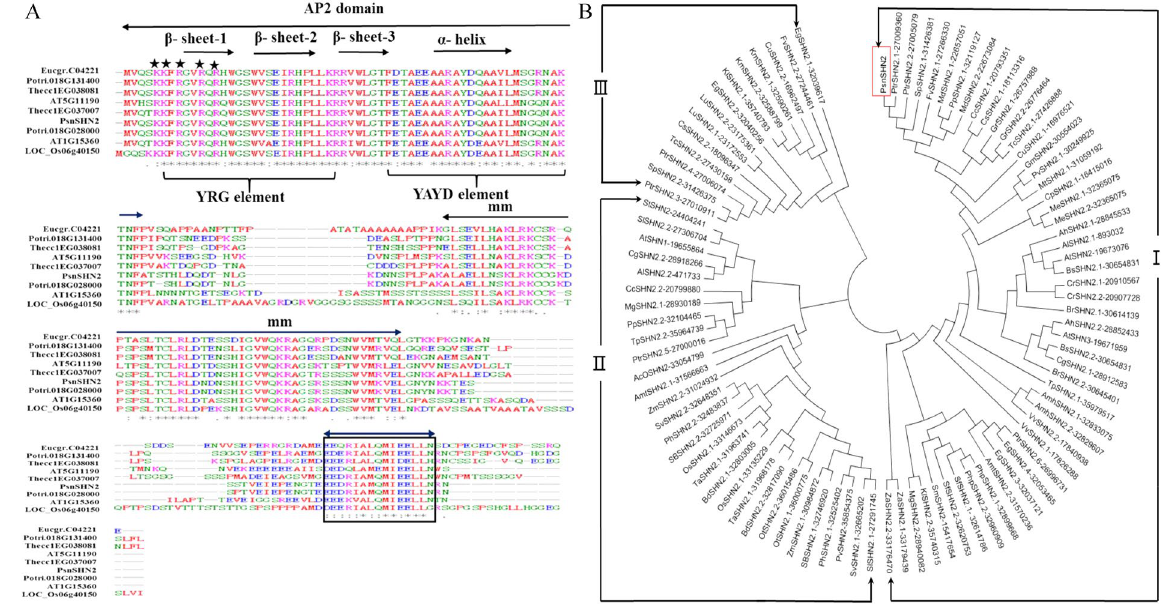
Figure 1. Protein sequence alignment and phylogenetic analysis of PsnSHN2 . ( A ) PsnSHN2 was aligned with SHINE proteins from Populus trichocarpa (Potri.018G028000 and Potri.018G131400), Eucalyptus globulus (Eucgr.C04221), Theobroma cacao (Thecc1EG038081 and Thecc1EG0370070), Oryza sativa (LOC_ Os06g40150) and Arabidopsis thaliana (AT1G15360 and AT5G11190). The conserved YRG and RAYD elements in AP2 domain are indicated by brackets. α helix is indicated by an arrow; cm stands for c-terminal domain while mm represents middle domain; Asterisks mark the putative domains for nuclear localization signals; the boxed region indicates the putative activation domain. ( B ) Phylogenetic analysis of PsnSHN2 with other SHINE proteins. 93 SHINE genes of 44 species are available in Supplemental file. PsnSHN2 is shown in a red rectangle. The number after short dash is gene ID number from the phytozome